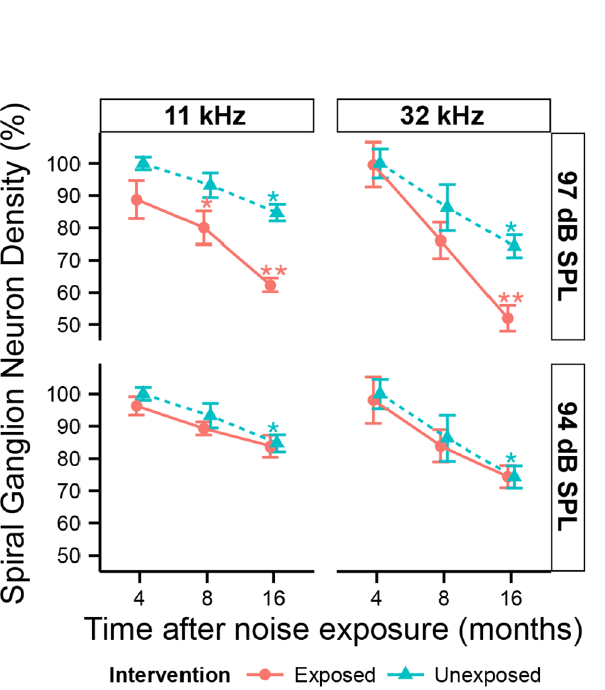
Fig 9. Late-onset loss of cochlear neurons following neuropathic noise. Density of spiral ganglion neuron somata as a function of post exposure time, as seen in the ~11 kHz (left) and ~32 kHz (right) regions after exposure to neuropathic (97 dB SPL) or non-neuropathic (94 dB SPL) noise. Data are group means ( ± SD), expressed relative to data from the youngest unexposed ears. Statistical significance of the group differences is indicated by asterisks: * , p < 0 . 05 ; ** , p < 0 . 01 . N = 3 – 7 animals per time and noise exposure.